Question: Write the caption for this figure.
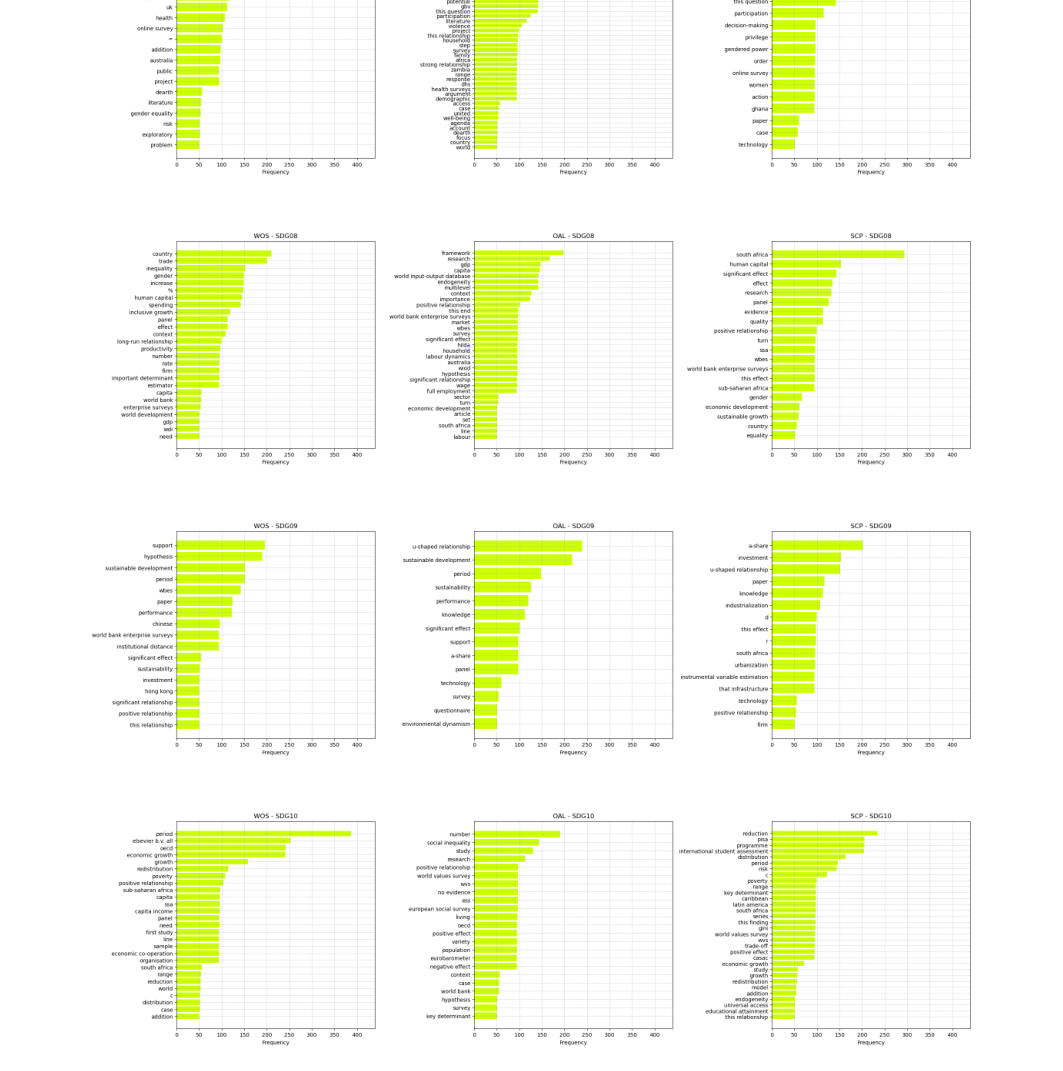
Answer: For each SDG and bibliometric DB, frequency bar charts of the ”unique” sets; i.e., noun phrases sets except those items that are in common among the three databases.